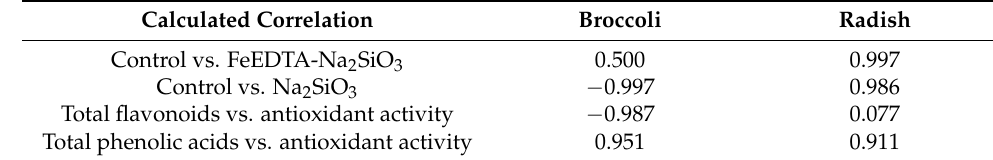
Table 6. Pearson’s correlation coefficients of antioxidant activity among control and used elicitors as well as between total flavonoids and phenolic acids and antioxidant activity in broccoli and radish